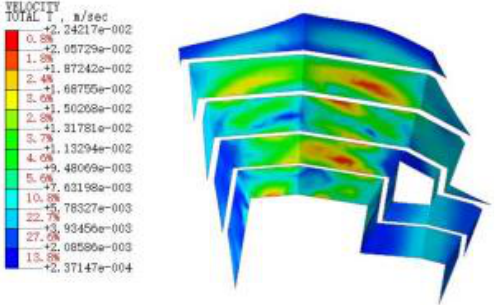
Figure 18. The vibration velocities of retaining walls at 300 ms.